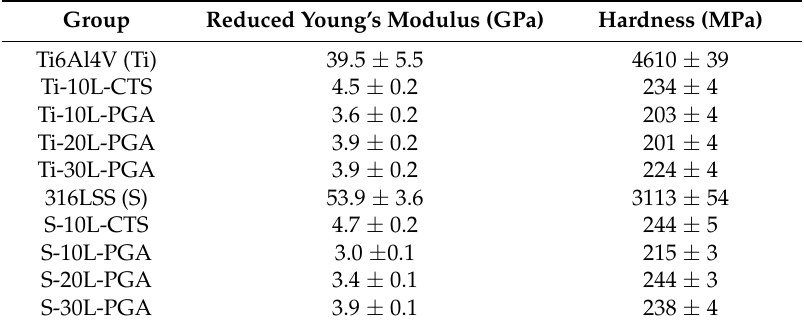
Table 1. Hardness and reduced Young’s modulus of the substrates with and without PEMs coating. The specimens are labeled according to the order of substrate material, number of layers and the outer coating material.